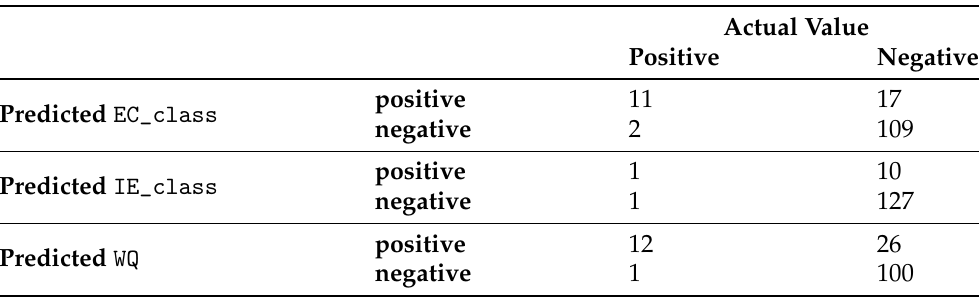
Table 8. Confusion matrices for binary classification of E. coli ( EC_class ), intestinal enterococci ( IE_class ), and combined model ( WQ ).